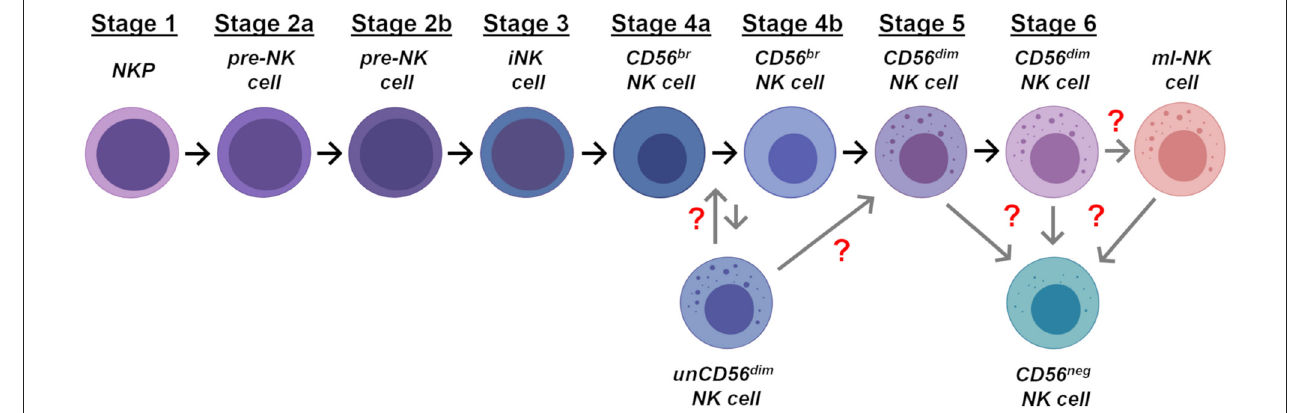
FIGURE 1 | Stages of NK cell ontogenesis. Schematic representation of the different stages of NK cell differentiation in human bone marrow and secondary lymphoid tissues. Gray arrows and red question marks indicate the possible location in NK cell development of unCD56 dim , CD56 neg , and ml-NK cells.